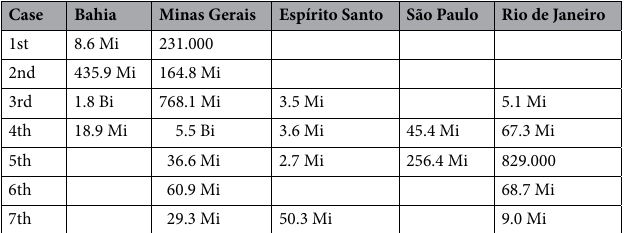
Table 3. Material damages and economic losses reported by municipalities during South Atlantic Convergence Zone (SACZ) cases, in Brazilian Real (BRL) currency. Source S2id (https:// s2id. mi. gov. br/).